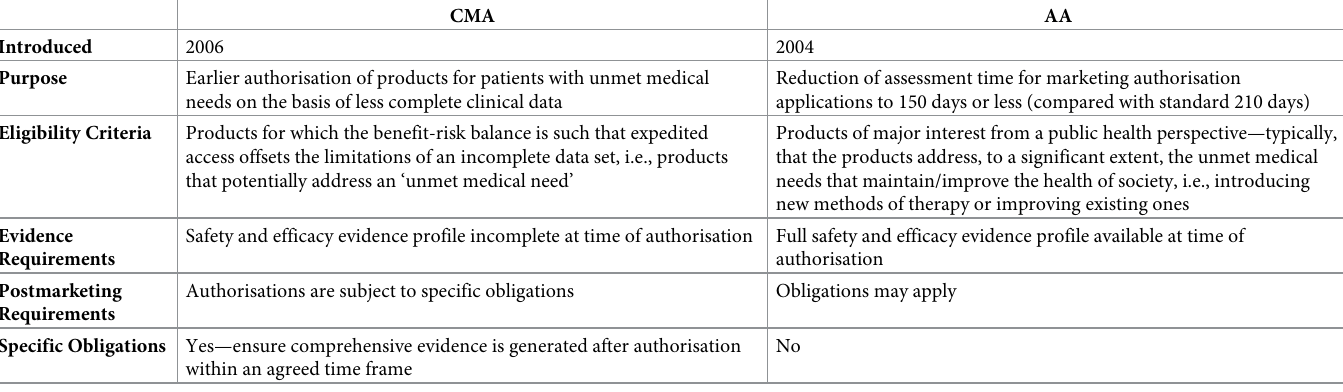
Table 1. Expedited pathways for early EMA marketing approval